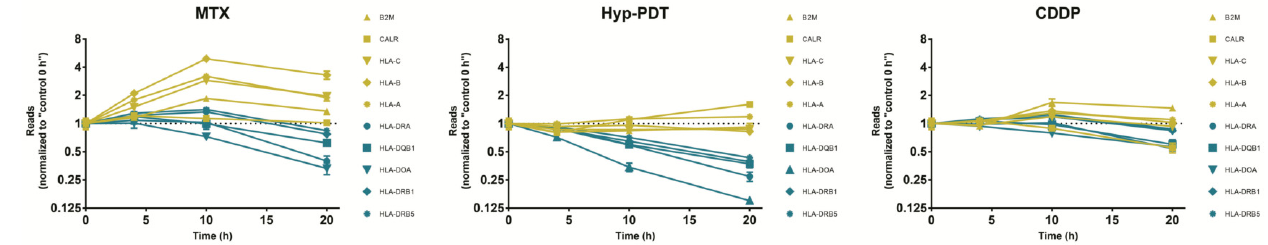
Figure 4. Pathway enrichment analysis. ( a ) Enrichment analysis of genes upregulated by RA/IFN α and predicted targets of miR-27-5a-p and miR-222-5p (Cluster 1) was conducted using the BiNGO app in Cytoscape. ( b ) Enrichment analysis of genes downregulated by RA/IFN α and predicted targets of miR-4284 and miR-212-3p (Cluster 1) was conducted using the BiNGO app in Cytoscape.